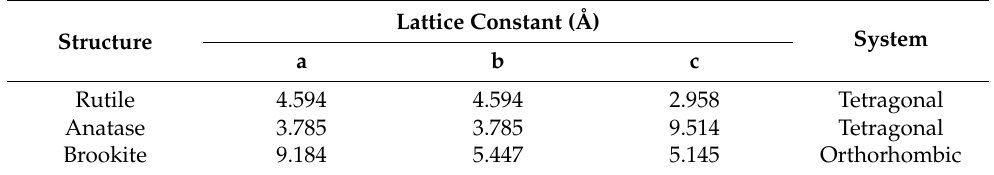
Table 4. Different phases of TiO 2 . Phase